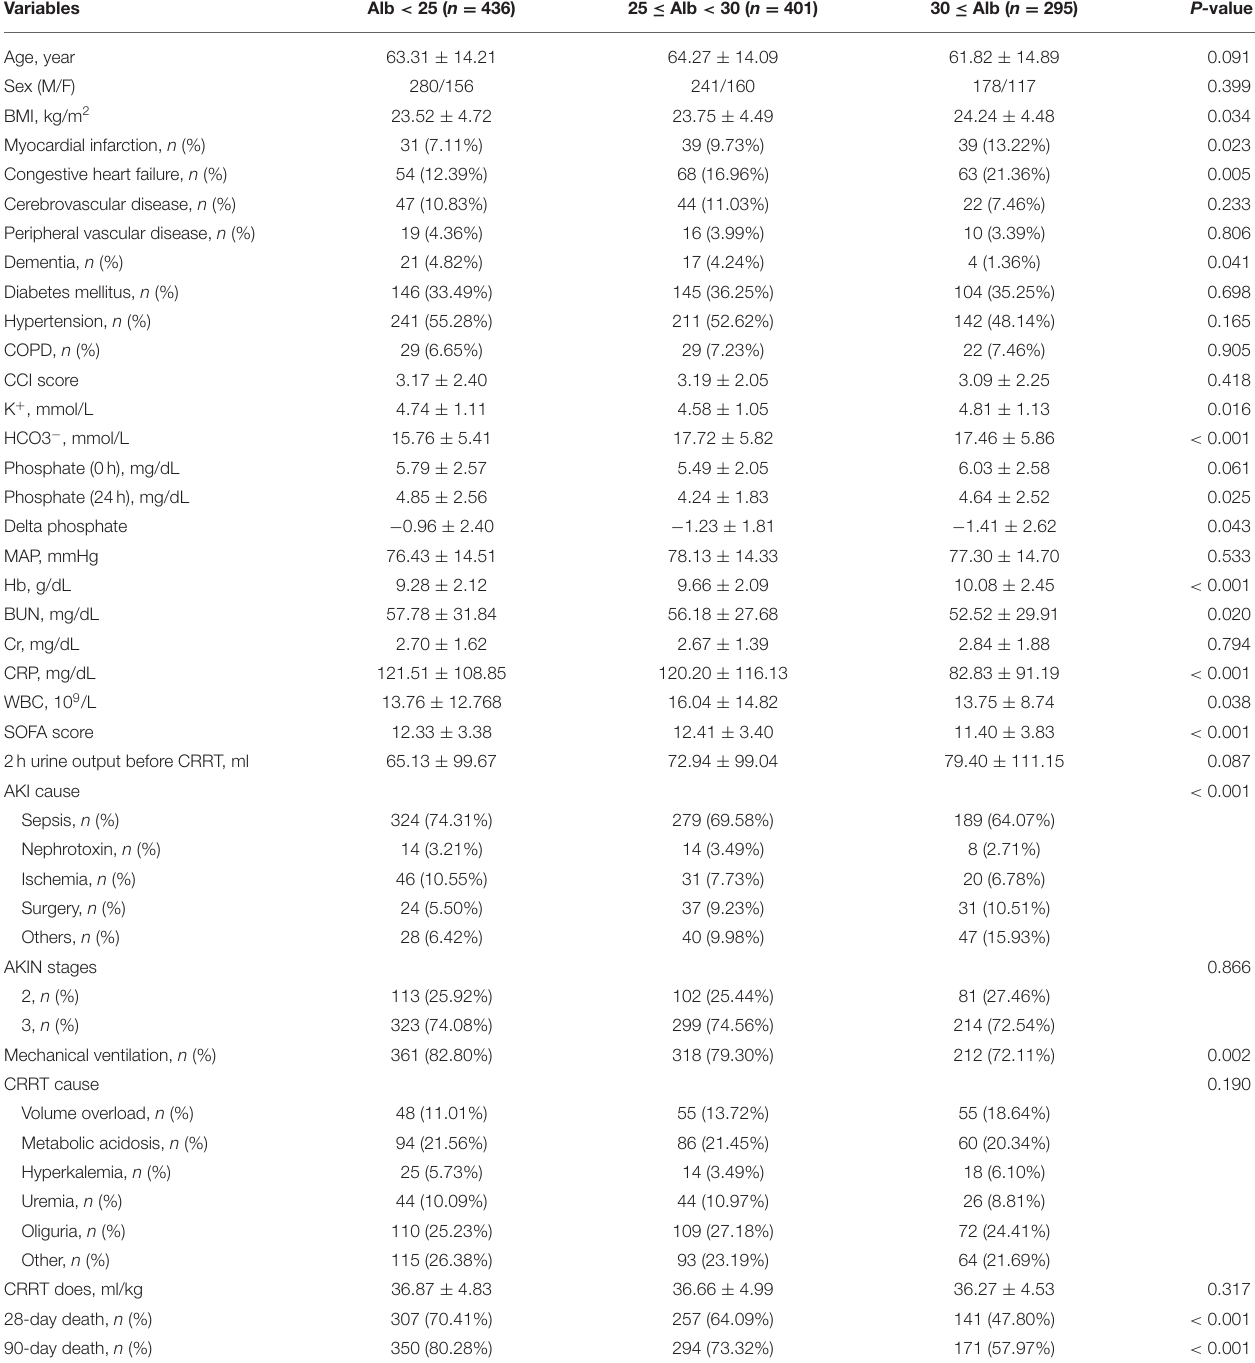
TABLE 1 | The clinical characteristics of